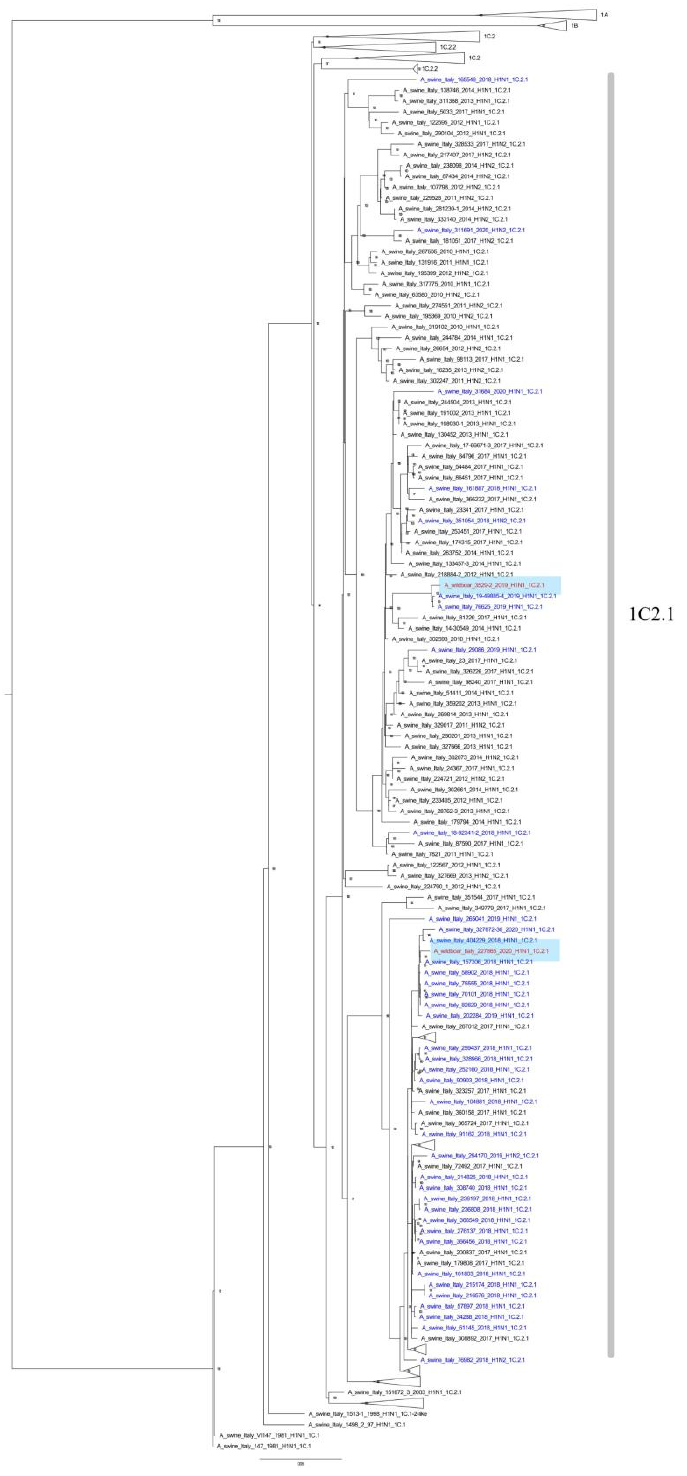
Figure 2. ML phylogenetic tree showing the wild boar A/wild_boar/Italy/3529/2019 and A/wild_boar/Italy/227865/2020 swIAVs detected in this work together with 316 HA-H1C Italian sequences (1575 nucleotides) of strains recently analyzed. The tree was inferred with 507 recently- described Italian sequences (ref. [29,38]) retrieved from GenBank and collected in the years 2009–2020. The detected wild boar swIAVs are written in red. Strains detected since 2018 are in blue, older strains are in black. Bootstrap values under 70% are not shown, clades 1A, 1B, 1C.2, and 1C.2.2 have been collapsed; scale bar represents the number of nucleotide substitutions per nucleotide site.